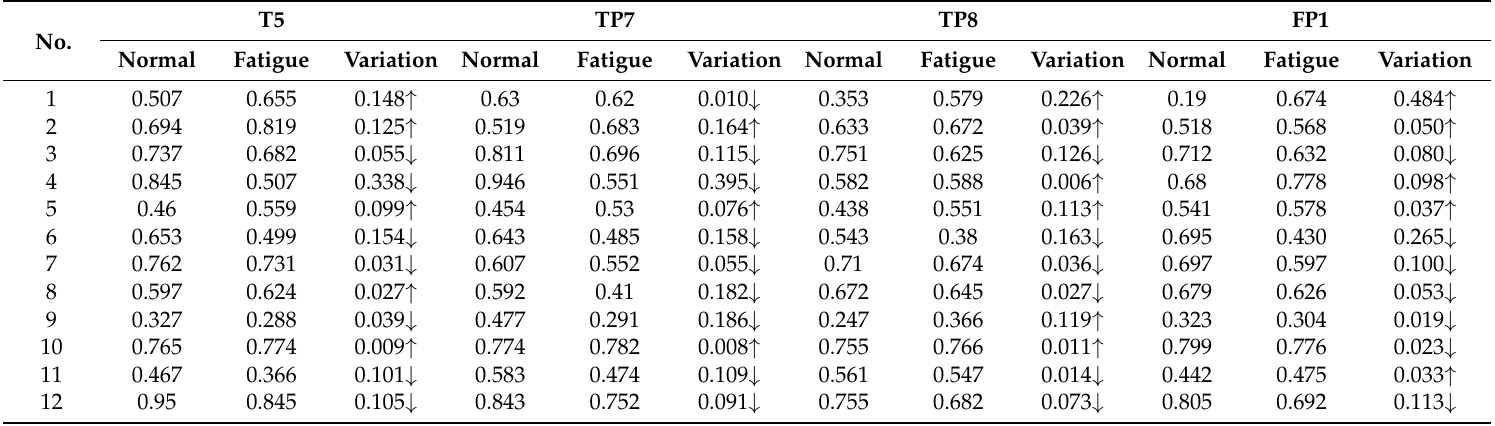
Table 3. The variation of entropy values on different